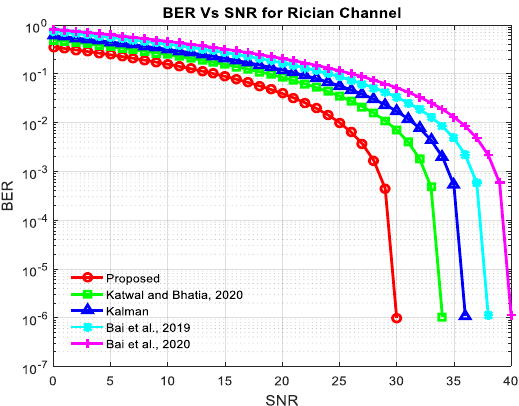
Figure 8. BER vs. SNR analysis for Rician channel